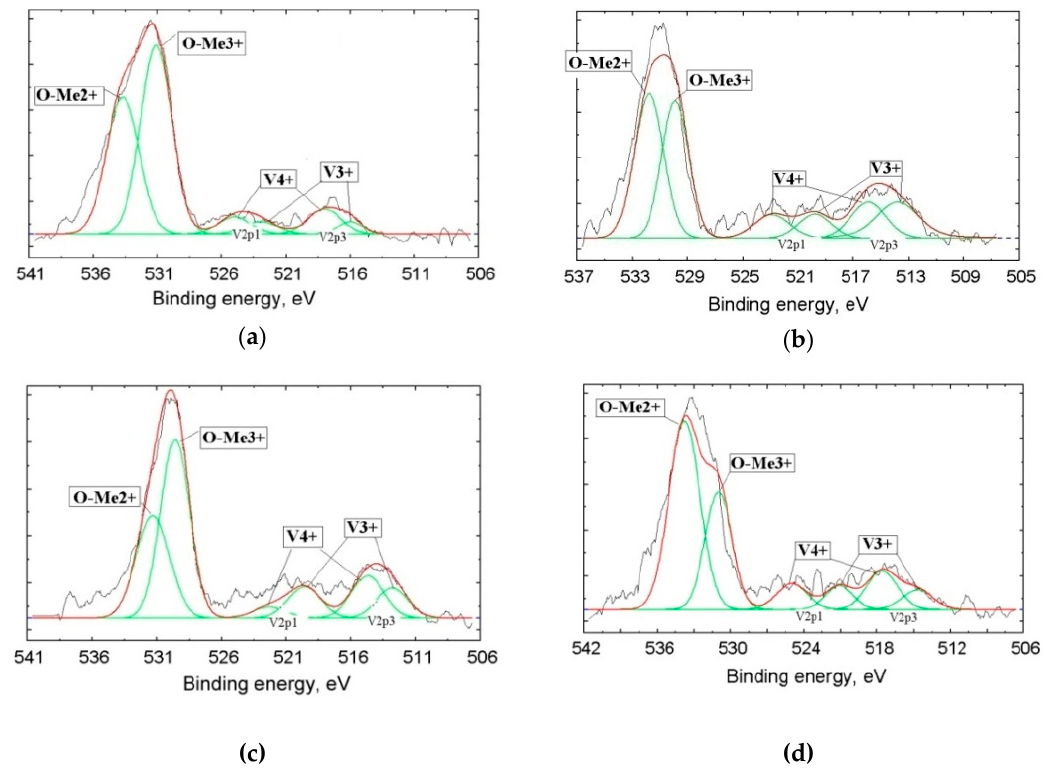
Figure 6. Fine structure of donor atoms (V) XPS (X-ray photoelectron spectroscopy) lines 2p 3/2–1/2 and O1s obtained from Samples 2 ( a ), 3 ( b ), 4 ( c ), and 5 ( d ).